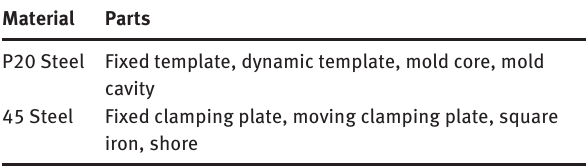
Table 1: The basic performance parameters of material polypropylene.